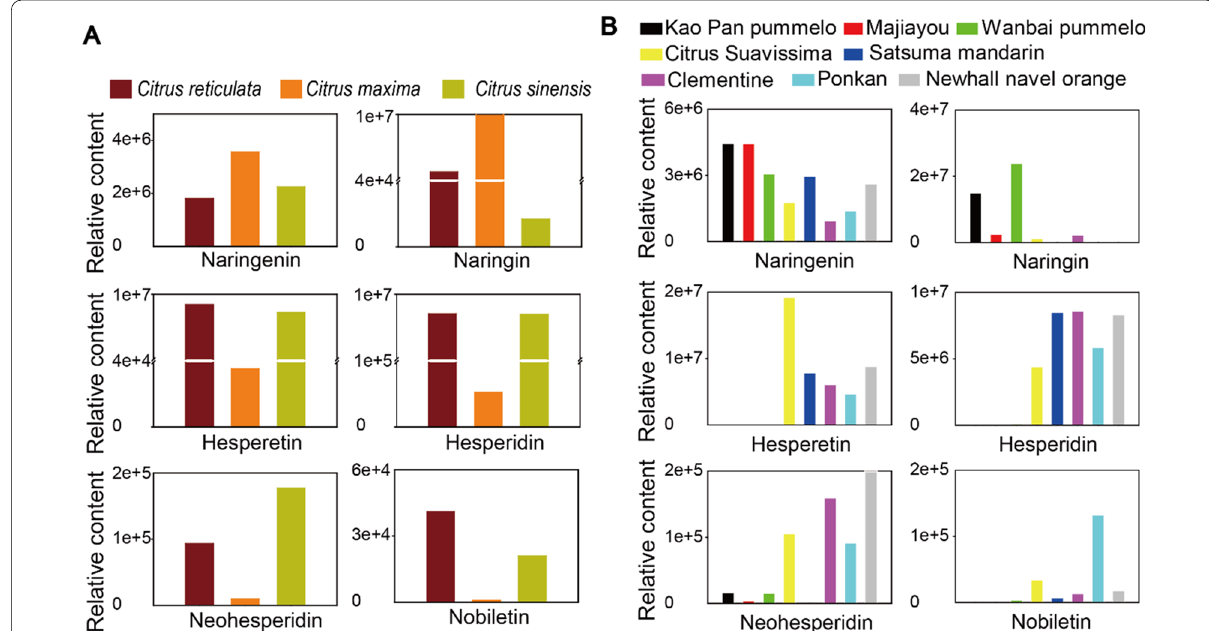
Fig. 2 The content of six compounds were analyzed by LC–MS/MS in different citrus species and cultivars. The data were analyzed by software, Lab Solution Insight LCMS. Peak area of ions signal repreasent relative content. A Distribution of naringenin, naringin, hesperetin, hesperidin, neohesperidin and nobiletin in different citrus species. B The content of six flavonoid compounds in different